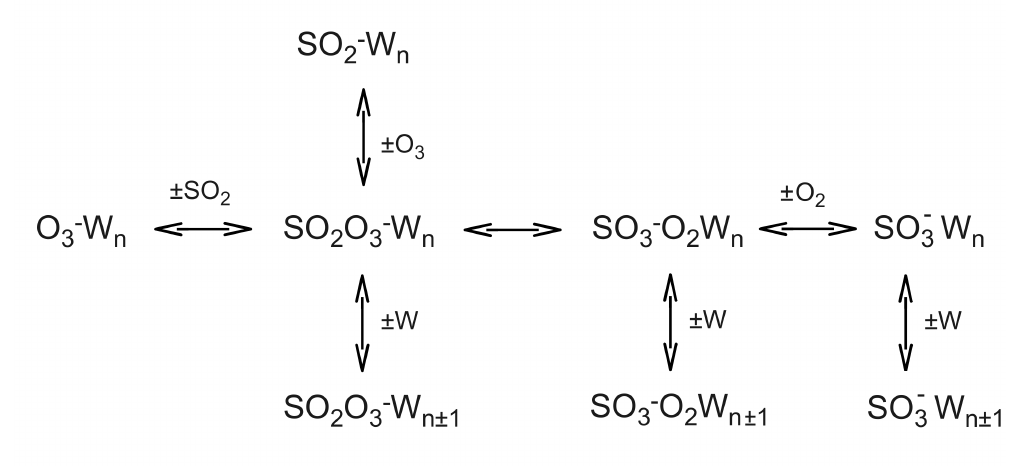
Fig. 1. Schematic overview of the investigated reactions. “W” is shorthand for water and up to 5 water molecules are here included. Under standard conditions and 50% relative humidity, the main products are SO −